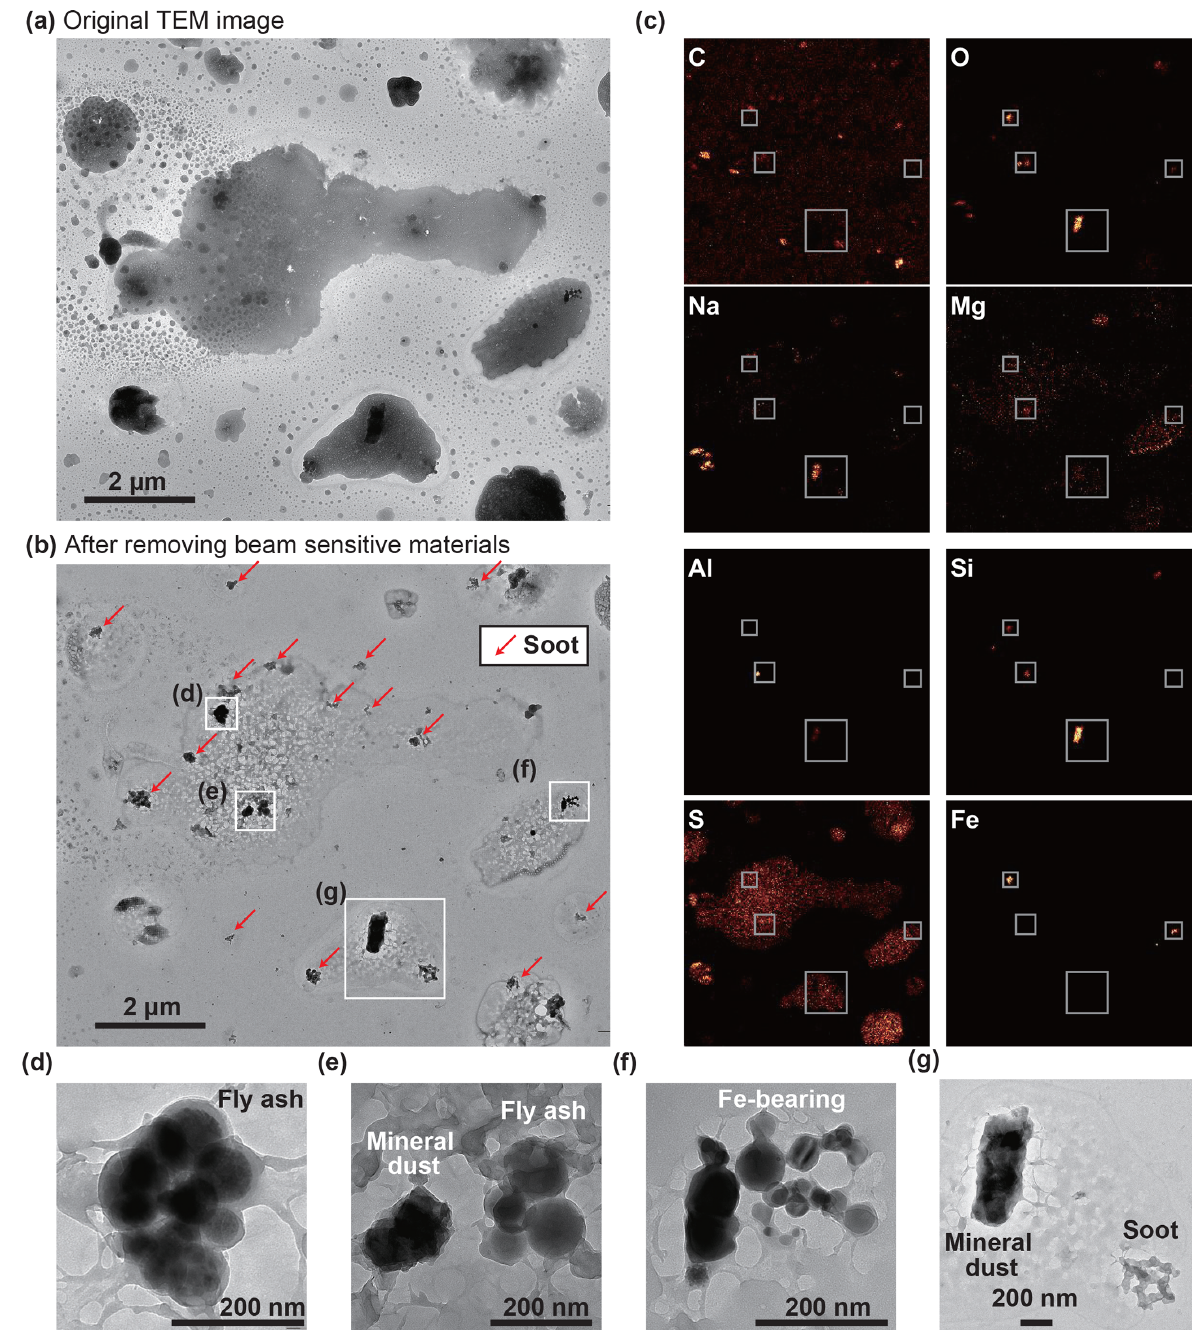
Figure 13. TEM and elemental mapping images of the sulfate particles with inclusions. (a) TEM image before the mapping analysis and (b) after the mapping analysis. Electron-beam exposure removed sulfate, and inclusions became more apparent. (c) Elemental mapping images of the TEM areas for the detected elements. (d) A fly-ash particle. (e) Mineral-dust and fly-ash particles. (f) An Fe-aggregate particle. (g) Mineral-dust and soot particles. The white squares in panels (b) and (c) indicate the areas of panels (d) – (g) . The sample was collected from 14:40–14:59UTC, 31 March